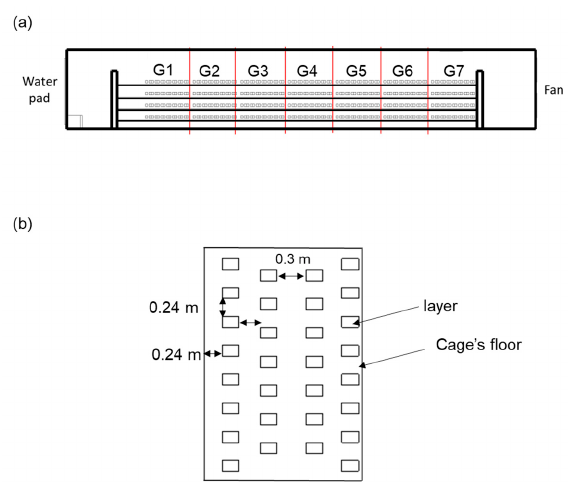
Figure 5. Information of cage. ( a ) Group of cages; ( b ) Schematic diagram of hens’ arrangement.